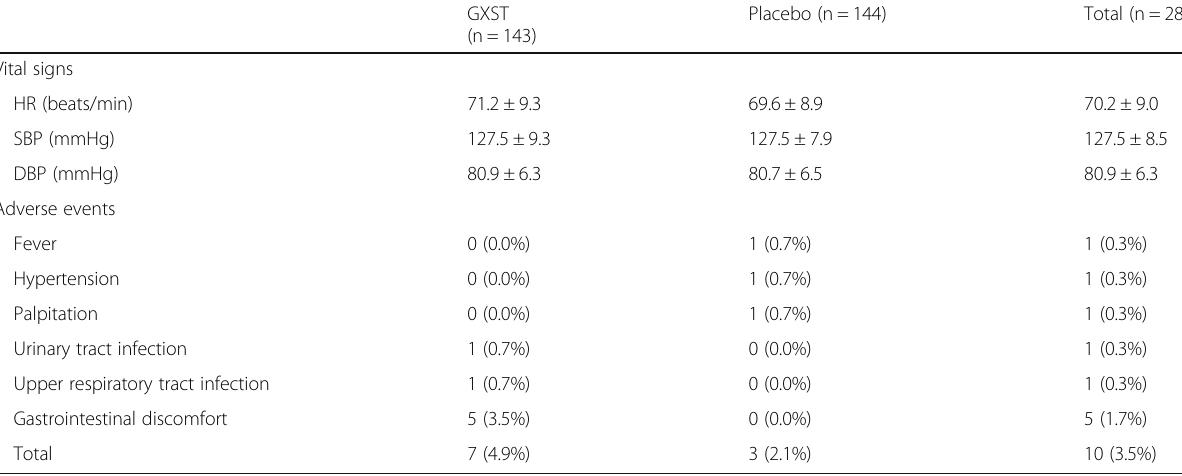
Table 4 Vital signs and most frequent treatment adverse